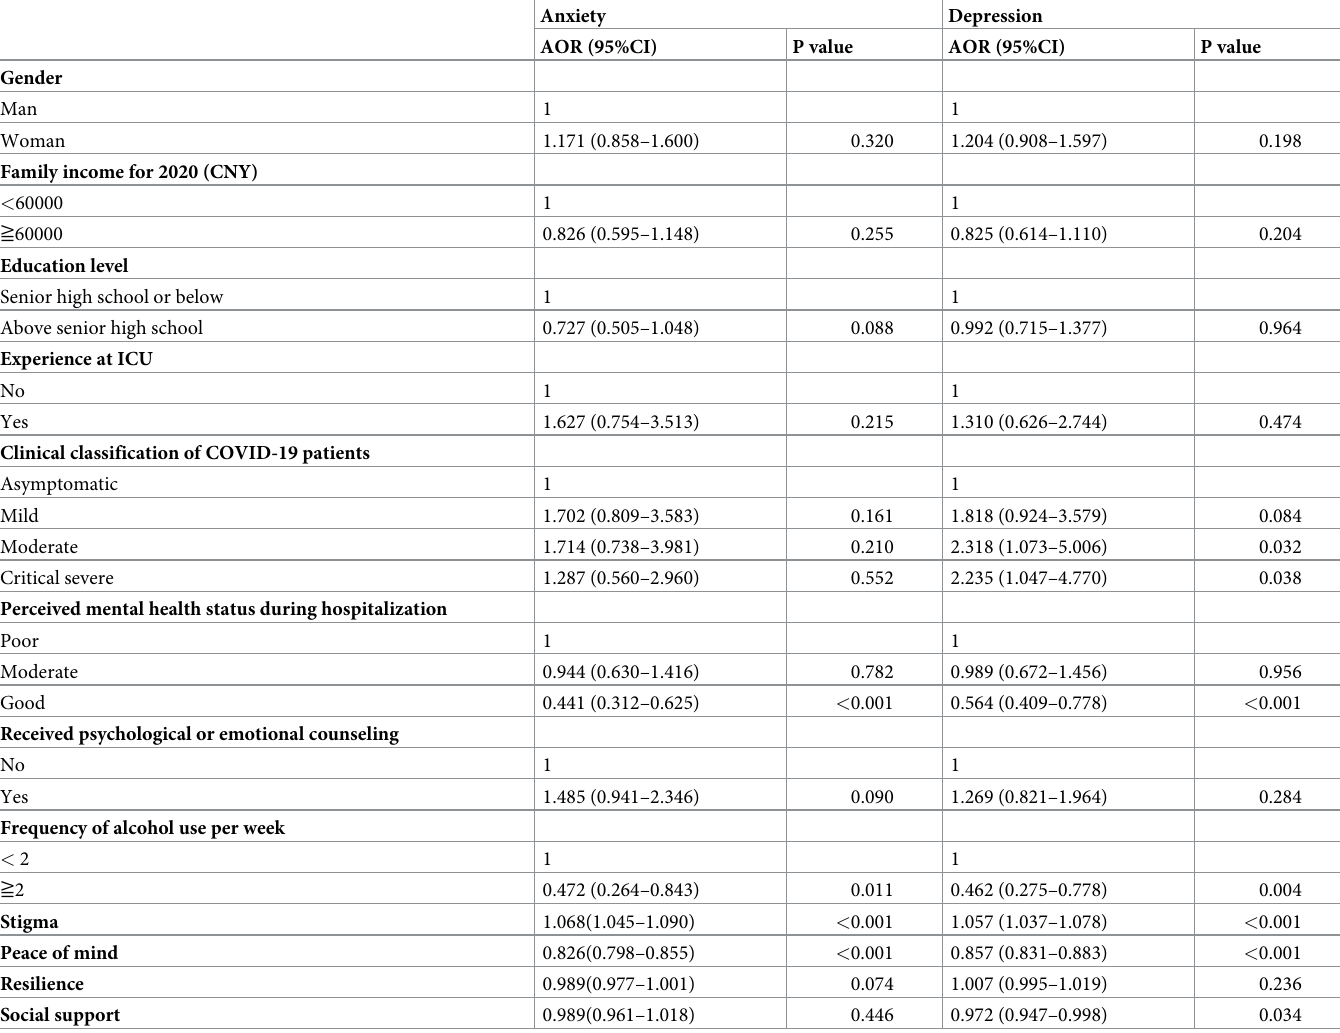
Table 5. Multivariate statistical analysis of adverse psychological outcomes in enrolled COVID-19